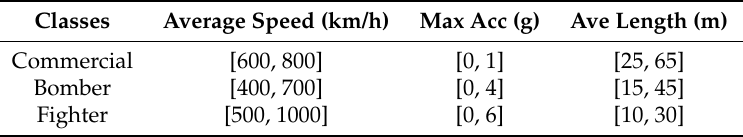
Table 3. Attribute intervals for the three airborne target classes.